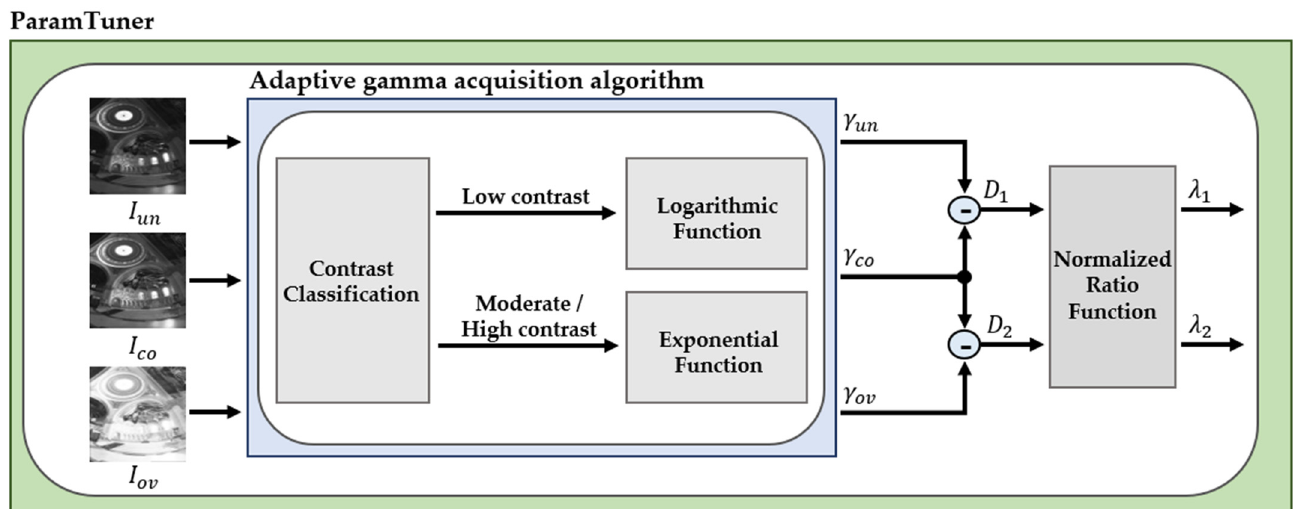
Figure 8. Detailed structure of the proposed ParamTuner.